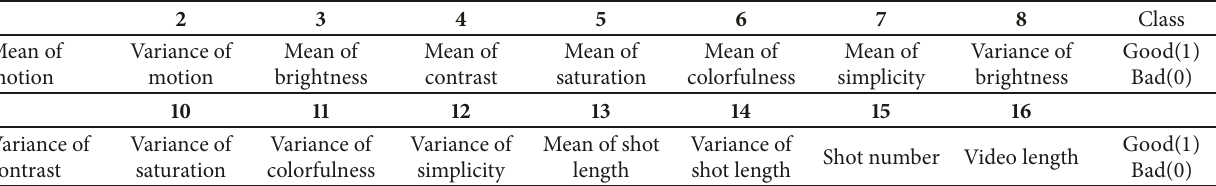
Table 7: Extracted video features and